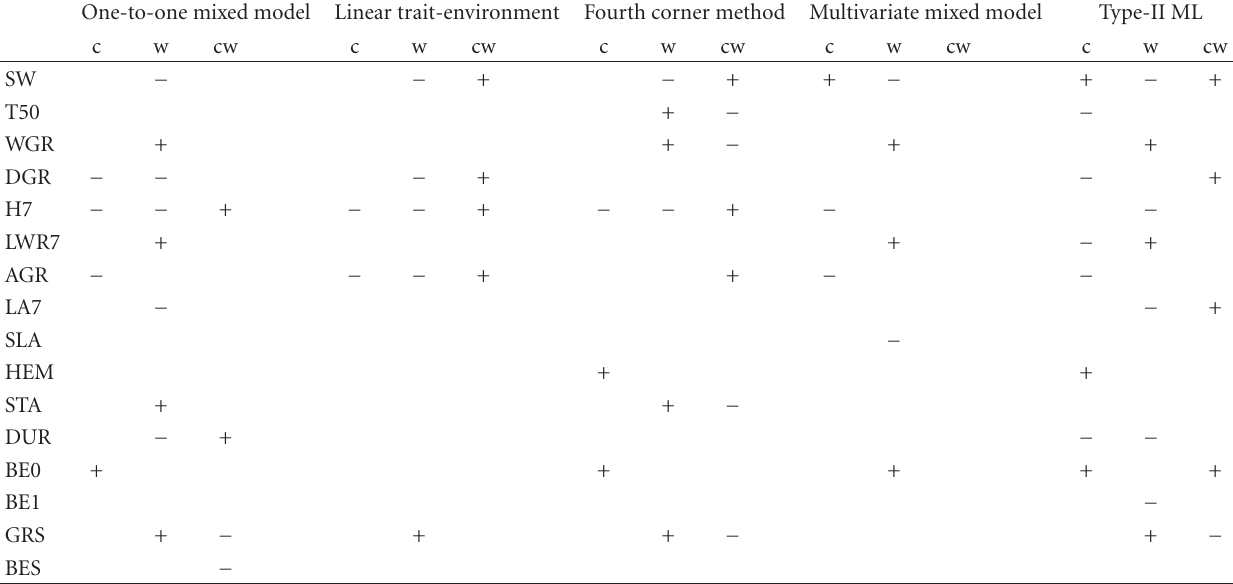
Table 2: Results of analysis from di ff erent methods using species biomass, species traits and environmental variables. The sign (+/ − ) represents the positive or negative significant Pearson’s correlation/coe ffi cients between the environmental variable and the species trait. For ease of interpretation, only significant relationships are